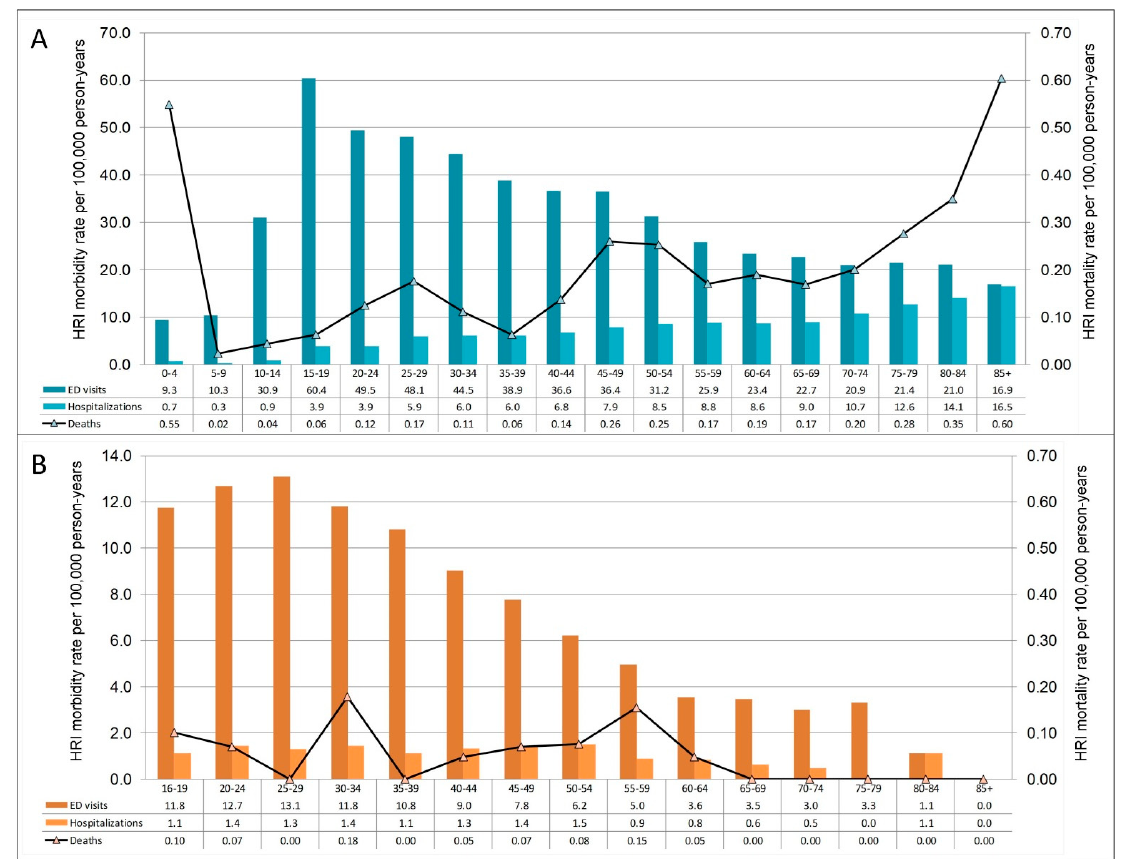
Figure 4. Age-specific rates of non-work-related ( A ) and work-related ( B ) HRI identified among Florida residents (2005–2012). All rates are per 100,000 person years. In panel ( A ), the non-work-related morbidity rates (left y-axis) are two orders of magnitude larger than the non-work-related mortality rates (right y-axis). In panel ( B ), the age distribution for work-related HRI starts at age 16, and the morbidity rates are approximately an order of magnitude larger than the mortality rates.